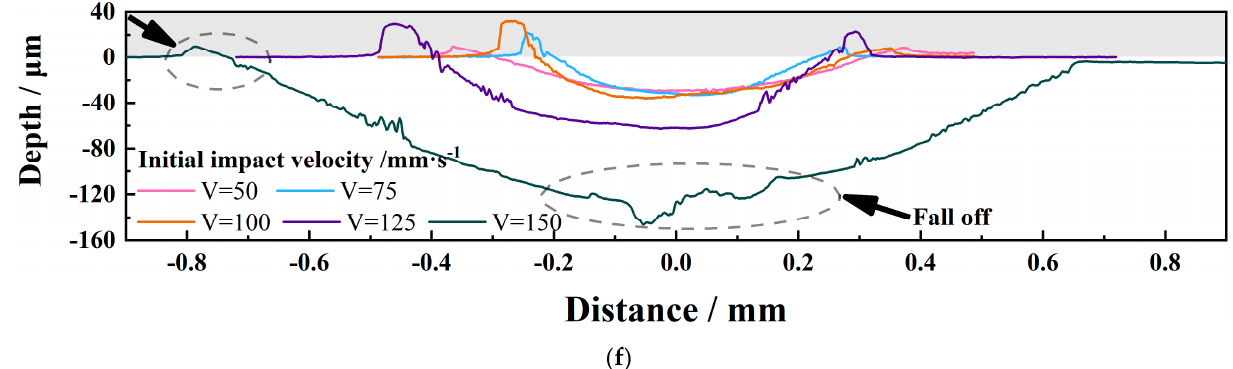
Figure 4. OM images and profile micrographs of the worn surfaces with varying initial impact ve- locities. ( a ) V = 50 mm/s, ( b ) V = 75 mm/s, ( c ) V = 100 mm/s, ( d ) V = 125 mm/s, ( e ) V = 150 mm/s, and ( f ) sectional profiles of worn scars under varying impact velocities.